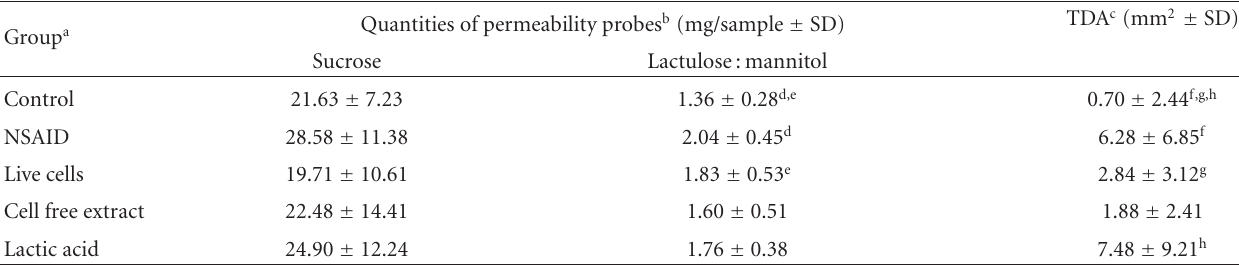
Table 5: E ff ect of Bifidobacterium lactis 420 cell-free extract and lactic acid against indomethacin-induced side e ff